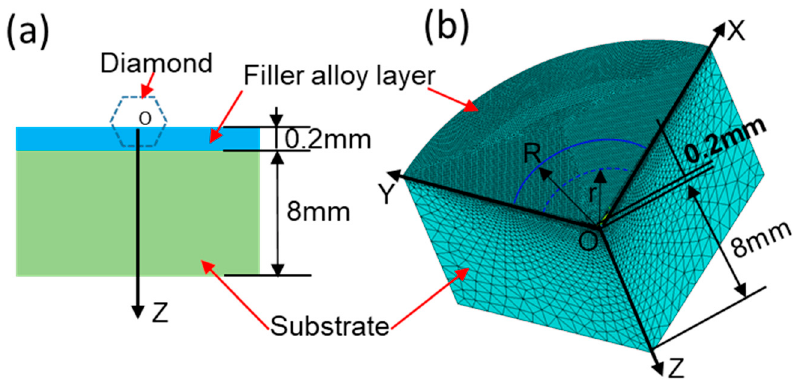
Figure 4. Finite element model of laser brazing. ( a ) The cross-sectional illustration of the diamond/filler alloy/substrate assembly; ( b ) the meshed model.